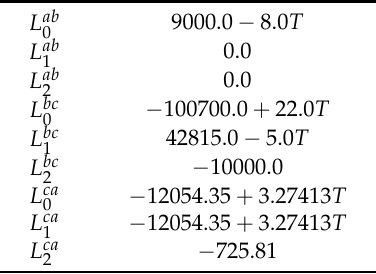
Table A2. Binary interaction parameter used for solid